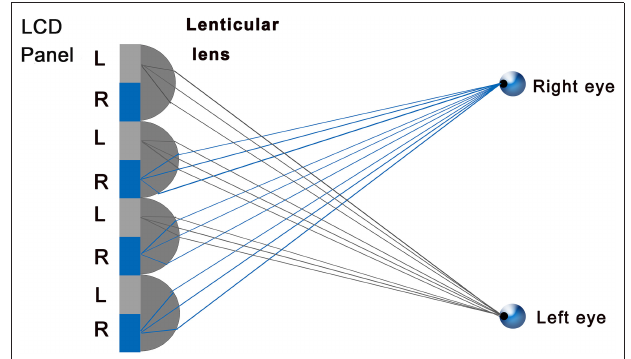
FIGURE 2 | Schematic diagram of image separation by the lenticular lens technique. The gray portion was seen by the left eye; the blue portion was seen by the right eye.